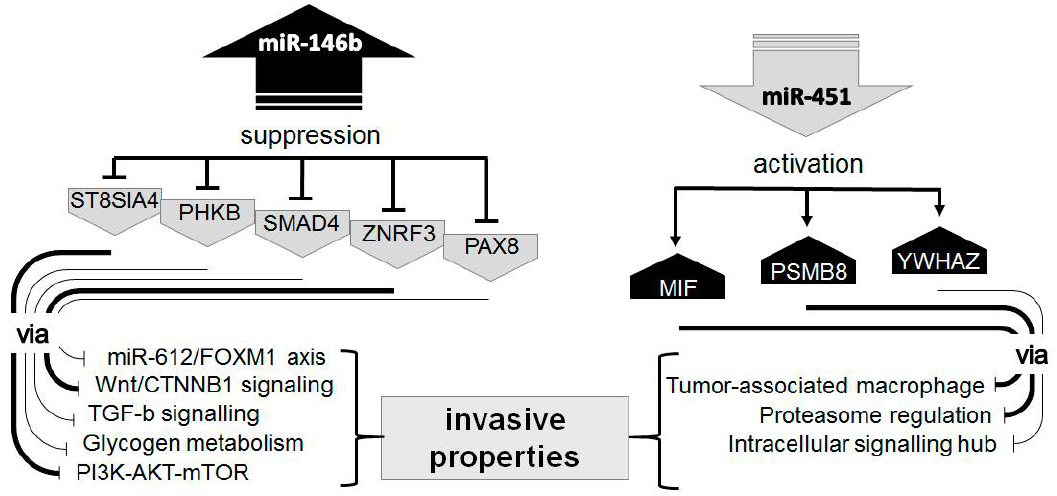
/ miR-451 downstream regulatory